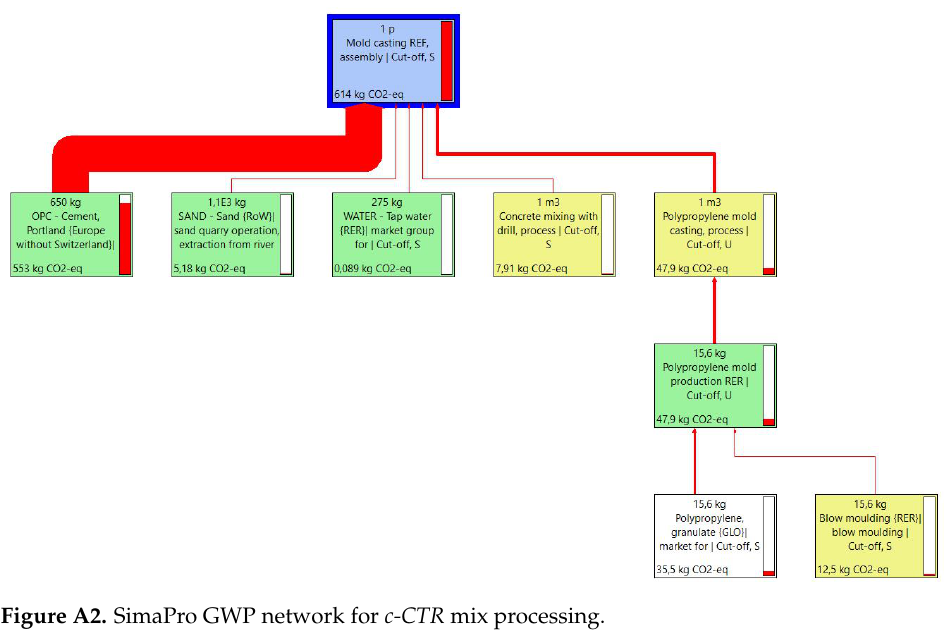
Figure A2. SimaPro GWP network for c-CTR mix processing.